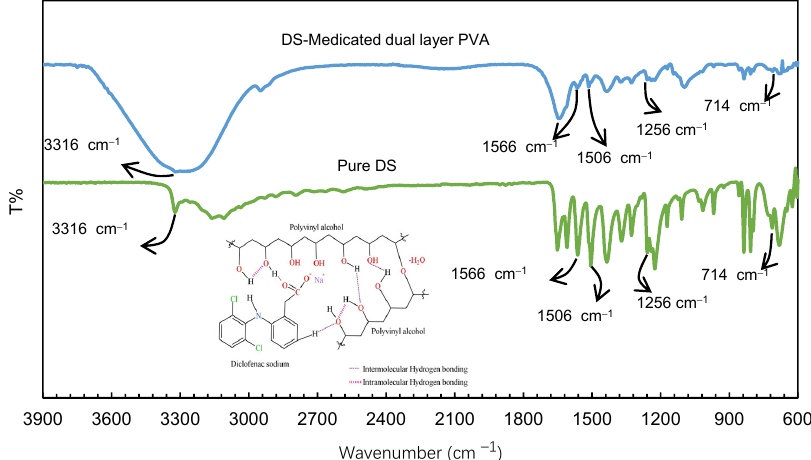
Figure 4. FTIR spectra of diclofenac sodium (DS) compatibility in dual layer PVA